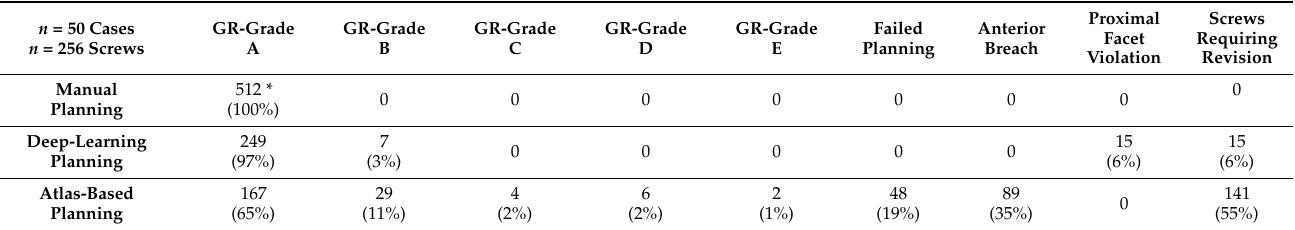
Table 3. Qualitative Screw